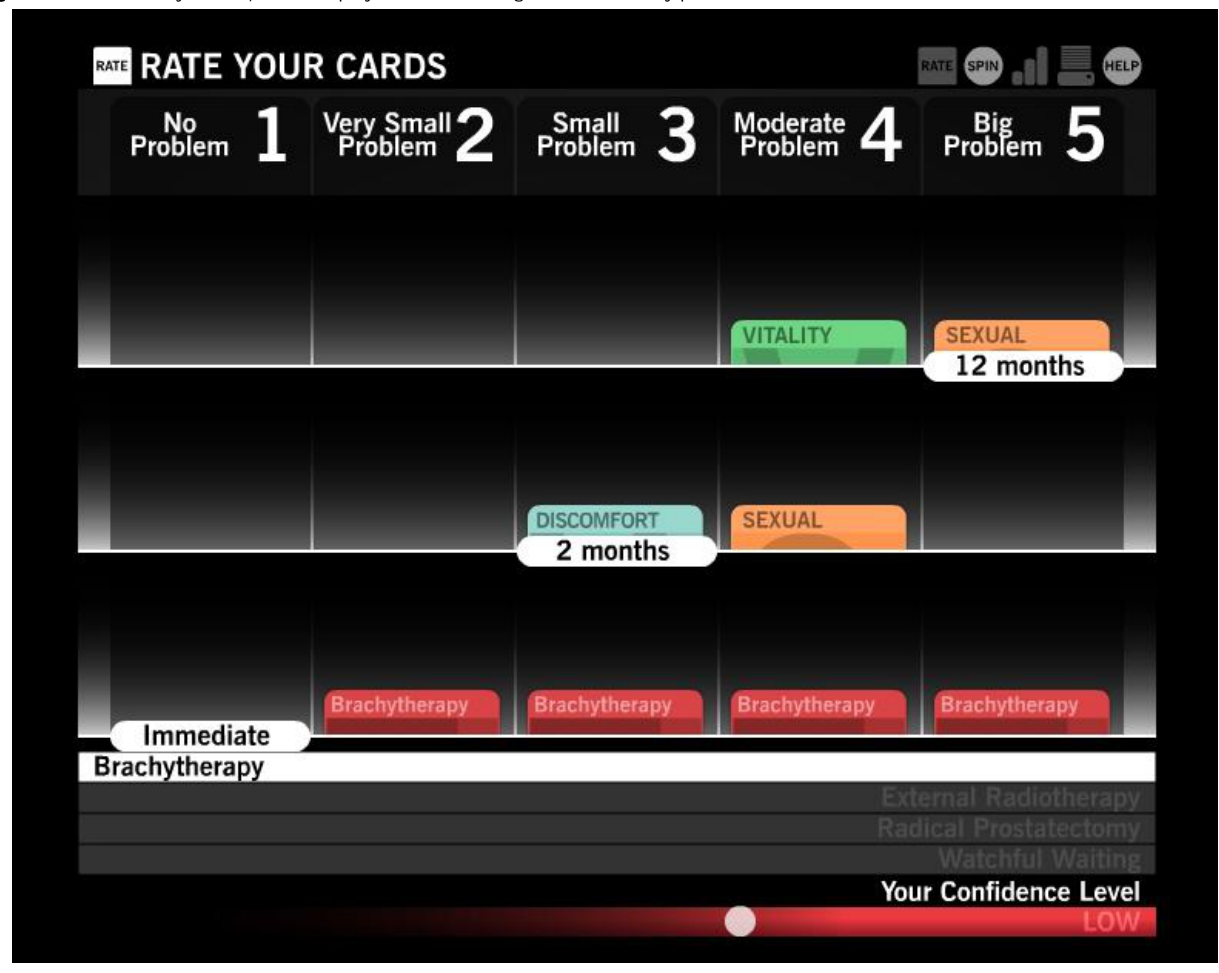
Figure 4. The summary screen, which displays the user’s rating of side effects by period and